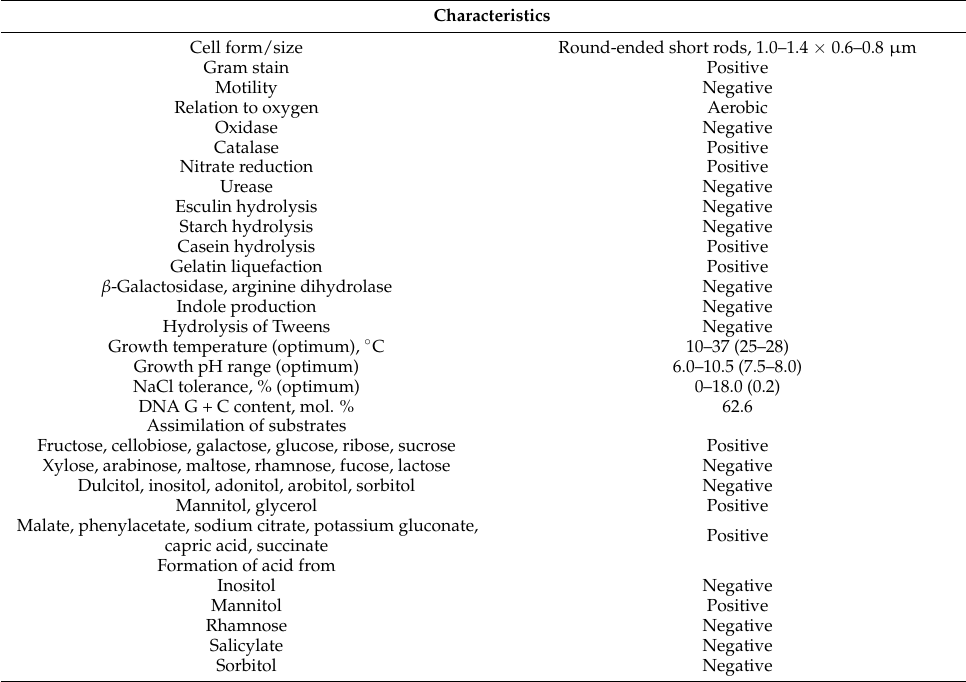
Table 1. Morphological, physiological, and biochemical characteristics of strain